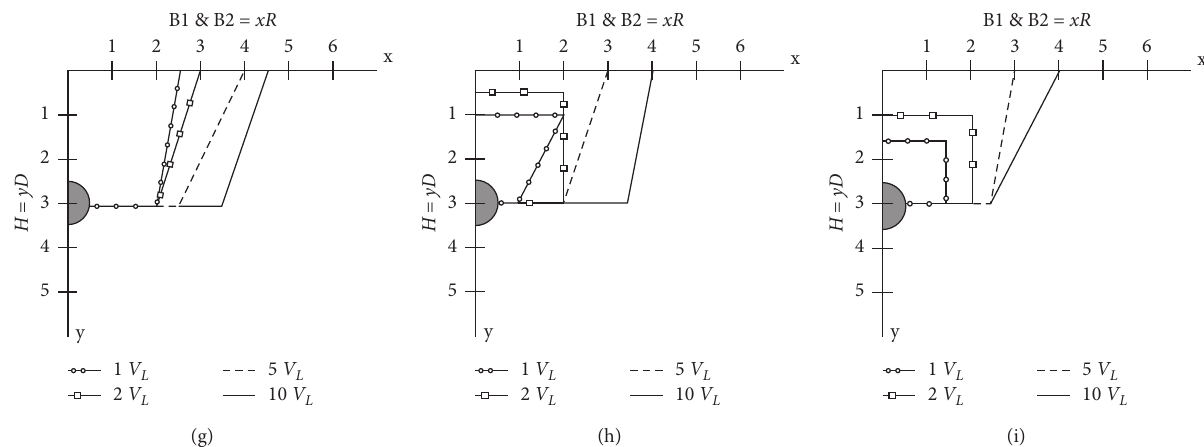
Figure 9: Influence zones for tunnel size, D � 9 m. (a)–(c) Tunnel placed at depth of tunnel size “ D ” for various volume loss percentage “ V (d)–(f) Tunnel placed at twice the depth of tunnel size “ D .” (g)–(i) tunnel placed at thrice the depth of tunnel size “ D .” (a) D � 9 m and z � 1 D in LS. (b) D � 9 m and z � 1 D in MDS. (c) D � 9m and z � 1 D in DS. (d) D � 9m and z � 2 D in LS. (e) D � 9m and z � 2 D in MDS. (f) D � 9m and z � 2 D in DS. (g) D � 9 m and z � 3 D in LS. (h) D � 9m and z � 3 D in MDS. (i) D � 9m and z � 3 D in DS.